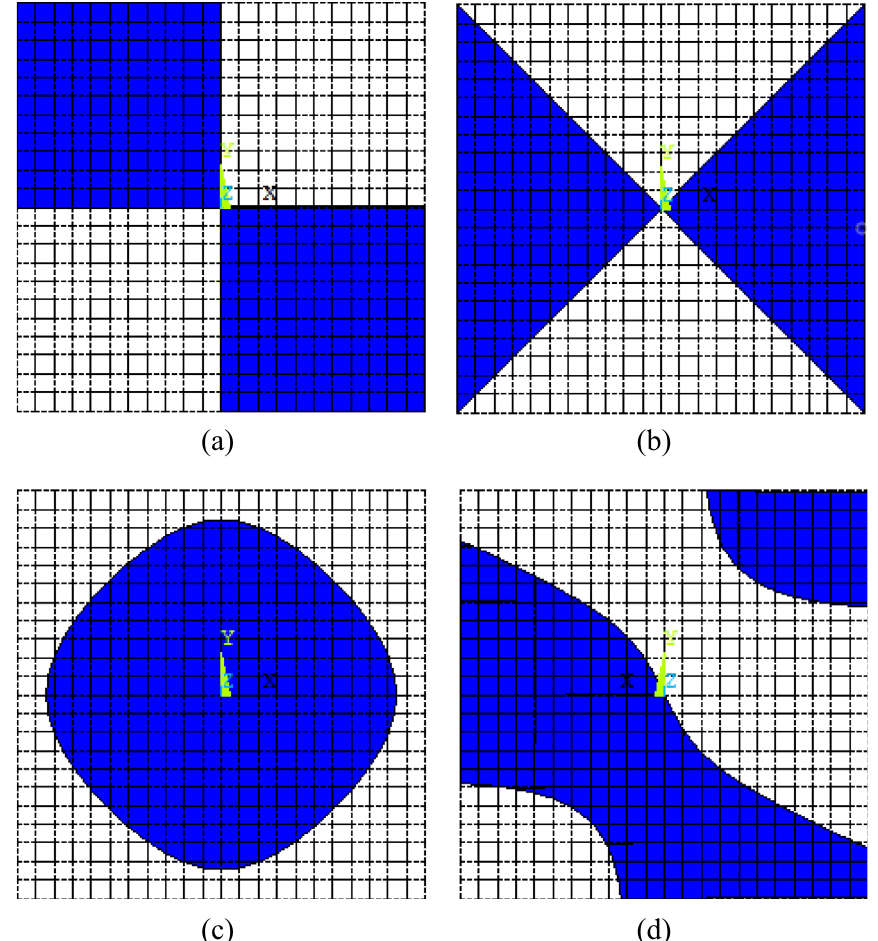
Figure 2. The fi rst four natural vibration mode shapes of an SFPR (a) 1st, (b) 2nd, (c) 3rd, and (d) 4th.